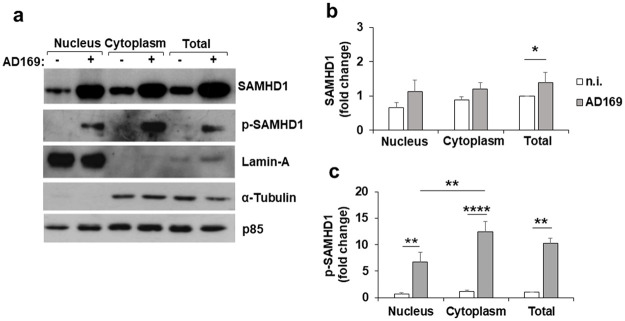
pT592-SAMHD1 is largely localized in the cytoplasm upon HCMV infection.a) HFFs were infected with HCMV at an MOI of 1 and nuclear, cytoplasmic, and total cell extracts were prepared at 3 dpi. Thirty μg of proteins were loaded and subjected to immunoblotting with the indicated antibodies. Lamin-A and α-tubulin were used to confirm fractionation efficiency, and p85 as loading control. Results derive from one representative experiment out of four. b-c) The relative amount of total (b) or pT592-SAMHD1 (c), normalized to that of p85, was determined by densitometric analysis and is relative to that of total cell extracts in n.i. cells, which was arbitrarily set as 1. Data are expressed as mean ± SE of four independent experiments. *, p < 0.05; **, p < 0.01; ***, p < 0.001; ****, p < 0.0001.